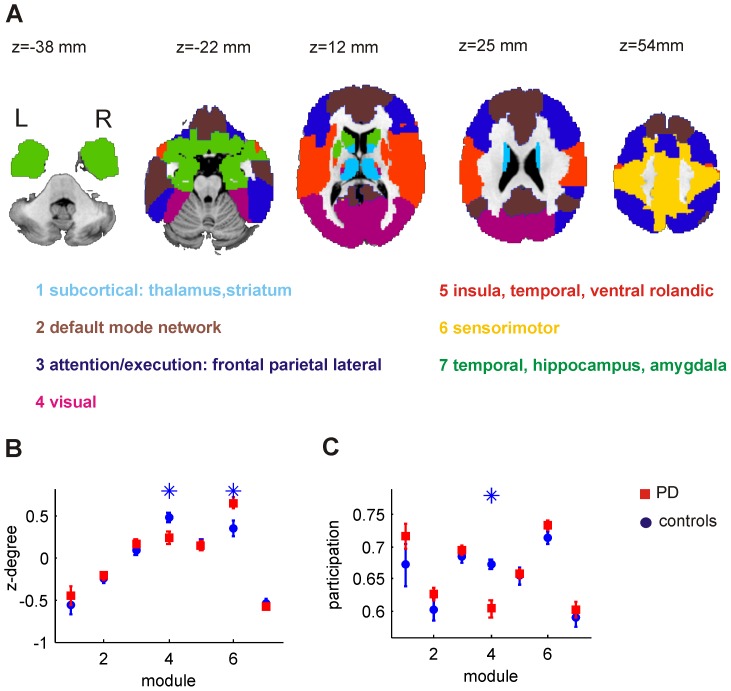
Modular structure of the brain network.A) Overview of the different network modules. B) mean z-degree of nodes comprising module C) mean participation nodes comprising module for patients (red squares) and controls (blue circles).